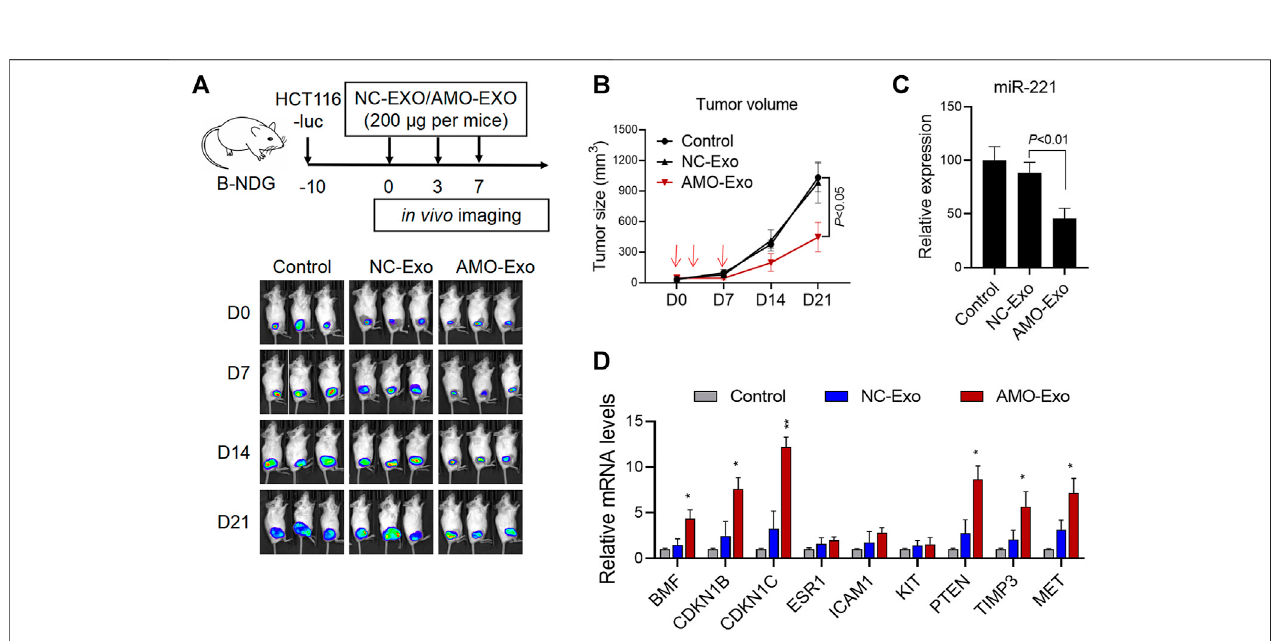
FIGURE 4 | AMO-loaded exosomes suppressed tumor growth in vivo . (A) HCT116 tumor-bearing mice received 3 intratumoral injections of exosome drugs on days 0,3,and7. Invivo imagingofthemicewasperformedonceaweektoobservethechangeof fl uorescencevalue. (B) Tumorchangesinmiceweremeasured witha vernier caliper. (C) The level of miR-221 in the dissected mouse tumor tissues was detected by quantitative PCR. (D) The mRNA levels of downstream target genes of miR-221 in the dissected mouse tumor tissues were detected by quantitative PCR. * p < 0.05, ** p < 0.01.